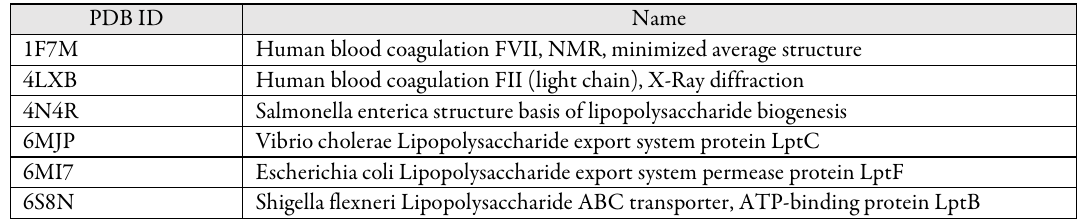
Table 1. Protein name and the PDB id PDB ID Name